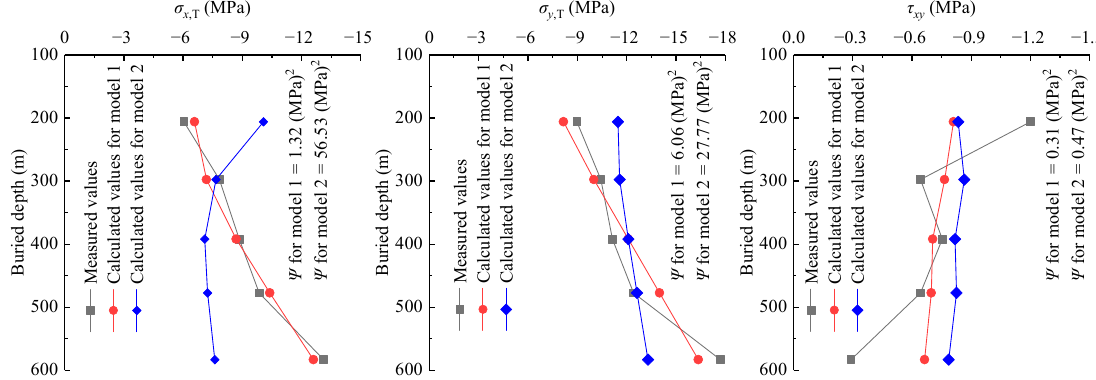
Figure 10. The comparison of the magnitude between measured in situ stresses and calculated ones.